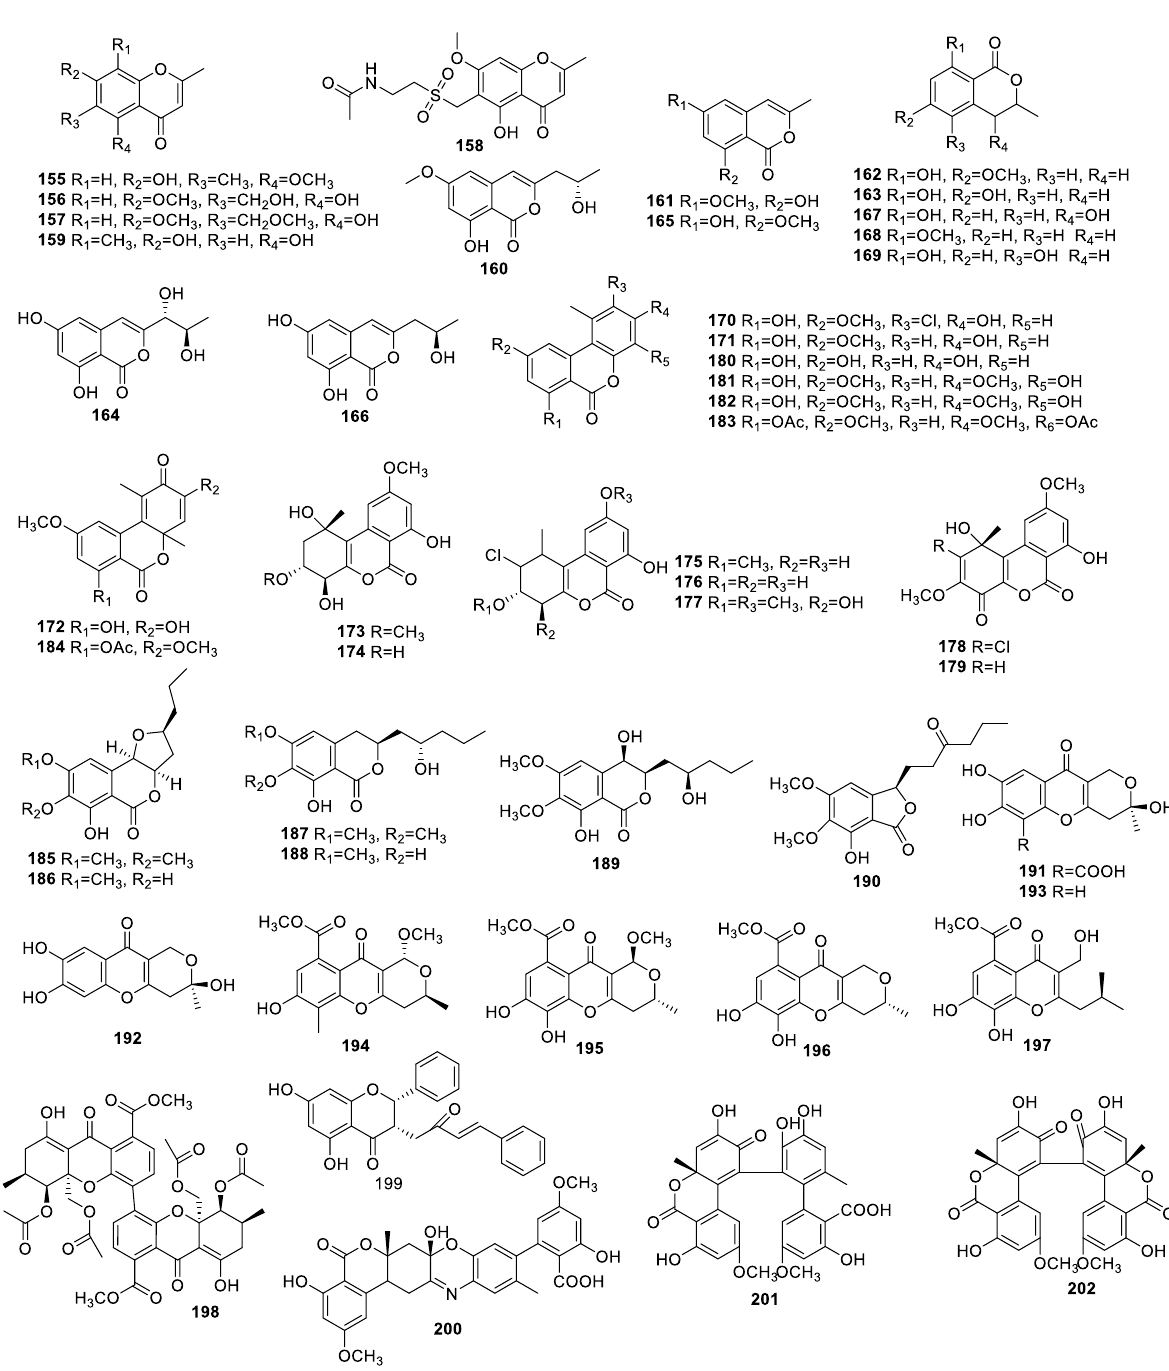
Figure 7. Chemical structures of benzopyrones ( 155 – 202 ). Five isocoumarins, monocerin ( 185 ); monocerin demethylated derivative ( 186 ); fusar- entin 6,7-dimethyl ether ( 187 ); fusarentin 6-methyl ether ( 188 ); fusarentin derivative ( 189 ); and phthalide ( 190 ) were collected from the Colletotrichum sp. CRI535-02 of Piperornatum . The IC 50 s of compounds 186 and 188 were 23.4 and 16.4 µ M for DPPH inhibition and 52.6 and 4.3 µ M for superoxide anion radical inhibition, respectively. Isocoumarins 185 – 187 showed excellent ORAC antioxidation with 10.8–14.4 ORAC units, and 190